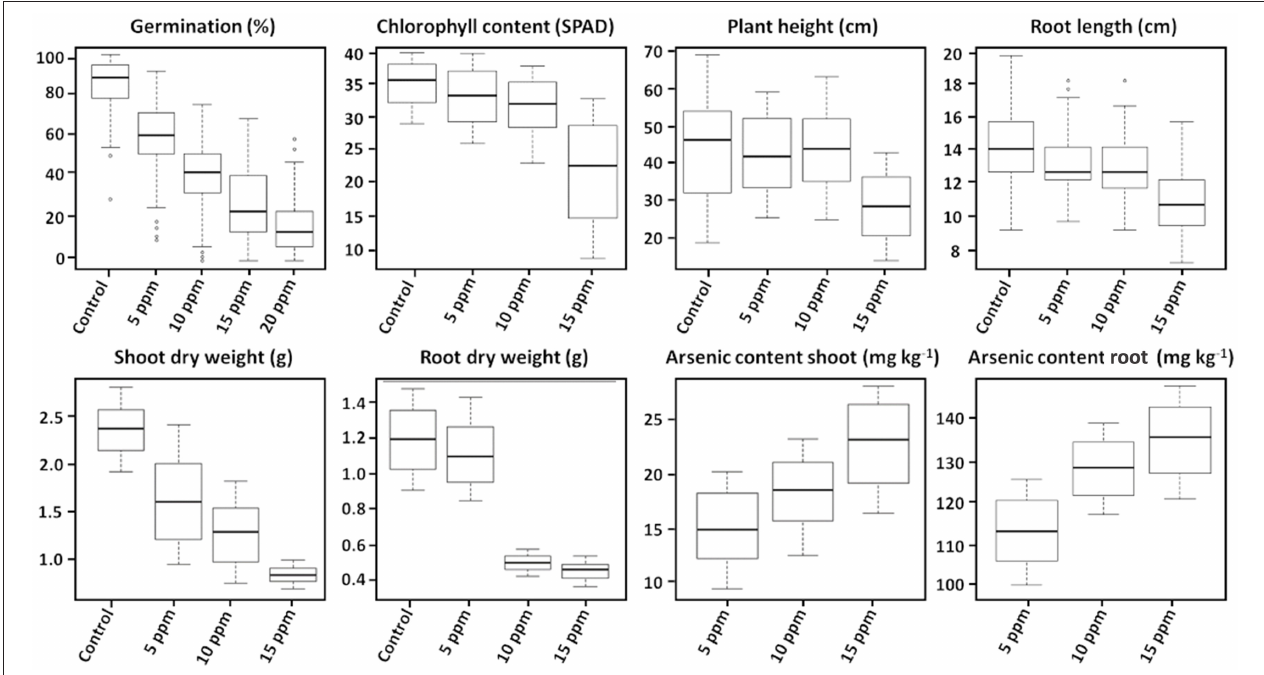
FIGURE 1 | Box plot showing the distribution of phenotype values in 53 different cultivars under arsenic stress. The thick line in the middle of the box is the median of the distribution while the lower and upper boundaries represent the first and third quartile, respectively. Lower and upper whiskers are calculated based on 1.5 times the inter-quartile range. Control, without arsenic treatment; 5, 10, 15, and 20 ppm represent different concentrations of arsenic treatments ( n = 3).